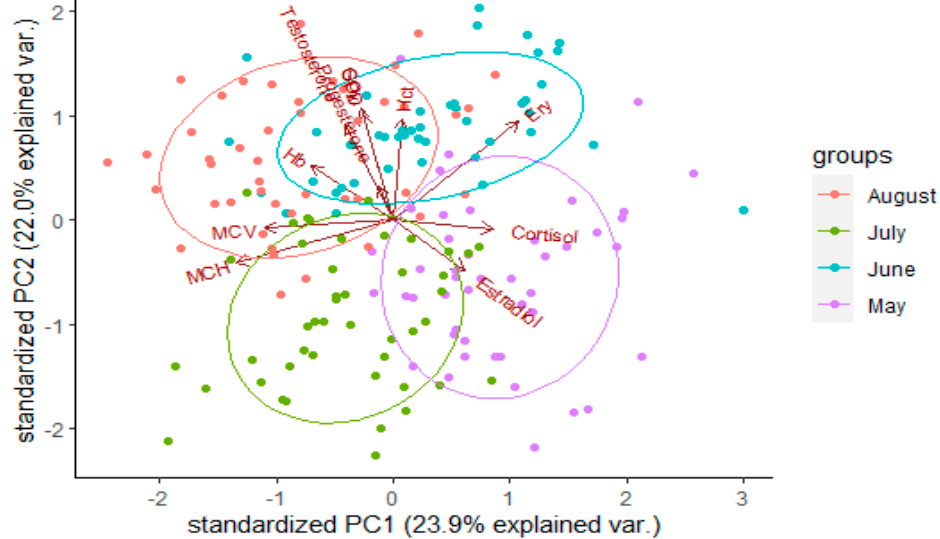
Figure 2. PCA of physiological parameters of rainbow trout ( Oncorhynchus mykiss ) measured in 2019 in four months, in three farms in Romania. RBC count varied significantly between farms (chi-squared = 12.193, df = 2, p = (Table 3). Higher values of the RBC count were found in fish from Ș oimul de Jos (2.85 × 1012/L) compared to fish from the other two farms (Fiad—2.48; Strâmba—2.57 × 1012/L) (Pairwise Wilcoxon rank sum test: p < 0.05 in all comparisons between Ș oimul de Jos and Fiad, and Ș oimul de Jos and Strâmba) (Figure 3a). Table 3. Summary table of the ANOVA/Kruskal–Wallis tests performed on physiological, hormo- nal, and hematological variables recorded over four months (May–August 2019) in three fish farms from Romania.